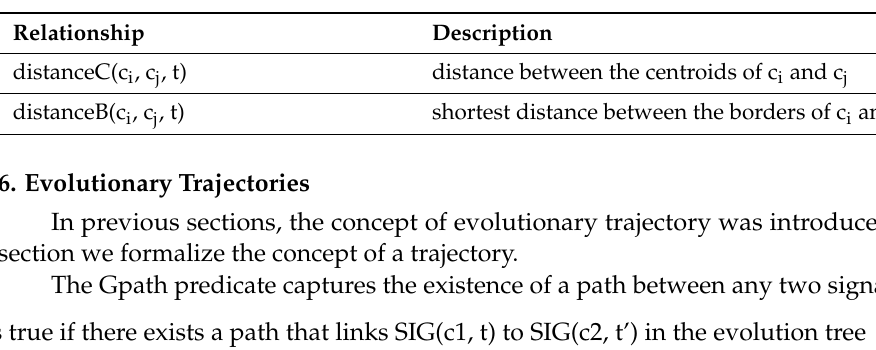
Table 1. Spatial Area Distance